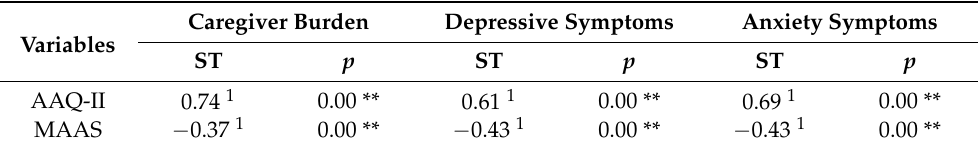
Table 9. Relationships between Psychological Flexibility and Mindfulness with Caregiver Burden, and Depressive and Anxiety Symptoms in Caregivers of PwD. Caregiver Burden Depressive Symptoms Anxiety Symptoms Variables ST p ST p ST p AAQ-II 0.74 1 0.61